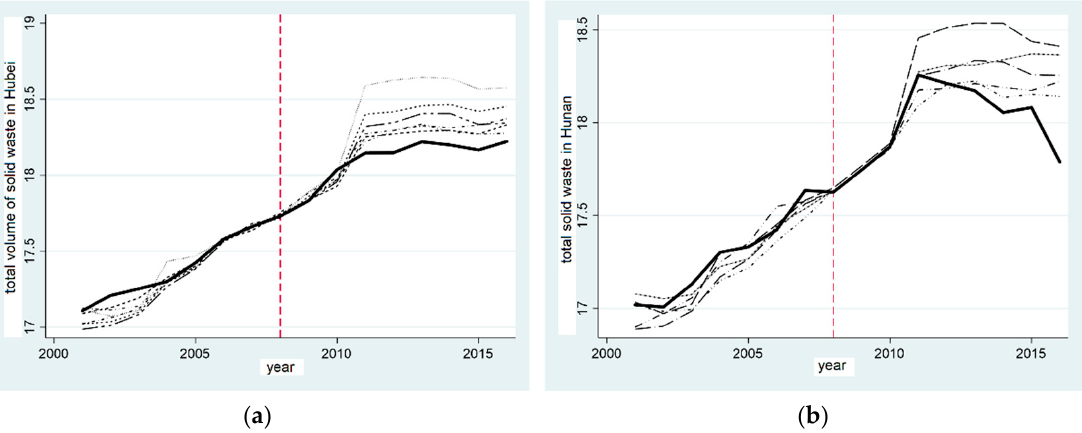
Figure 5. Sensitivity analysis of the total volume of general industrial solid waste emissions in the provinces established in the pilot zone of “two-oriented society”. ( a ) Hubei; ( b ) Hunan.